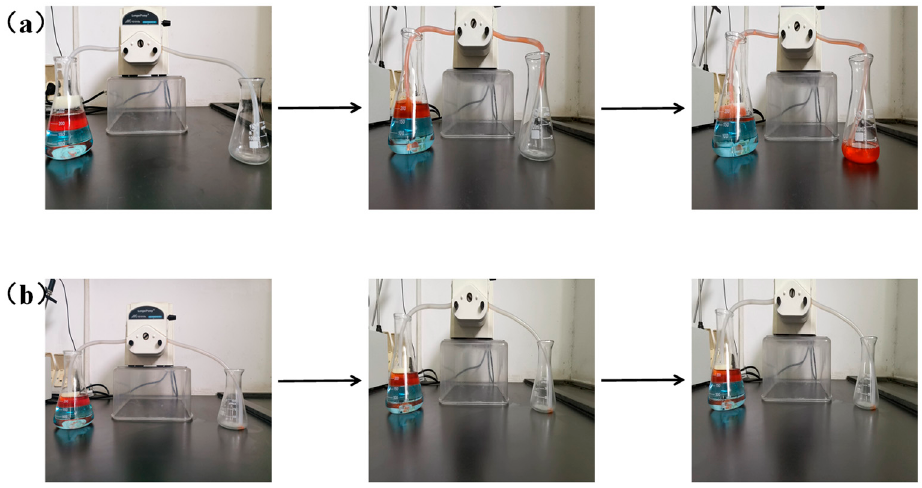
Figure 10. Separation of a mixture of diesel and water by the nano-HAp/PU sponge ( a ) and PU sponge ( b ).